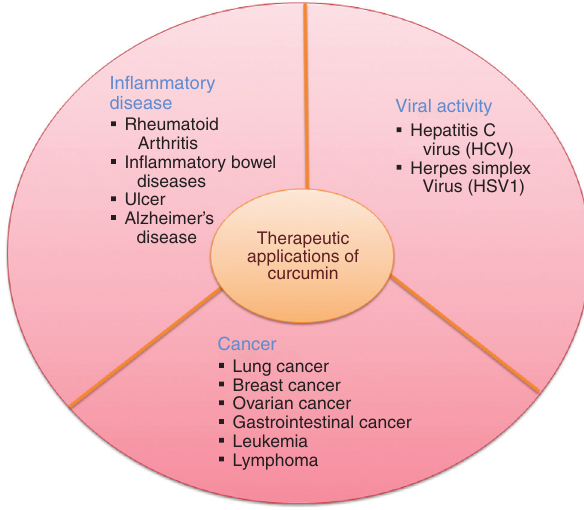
Figure 5: Therapeutic application of